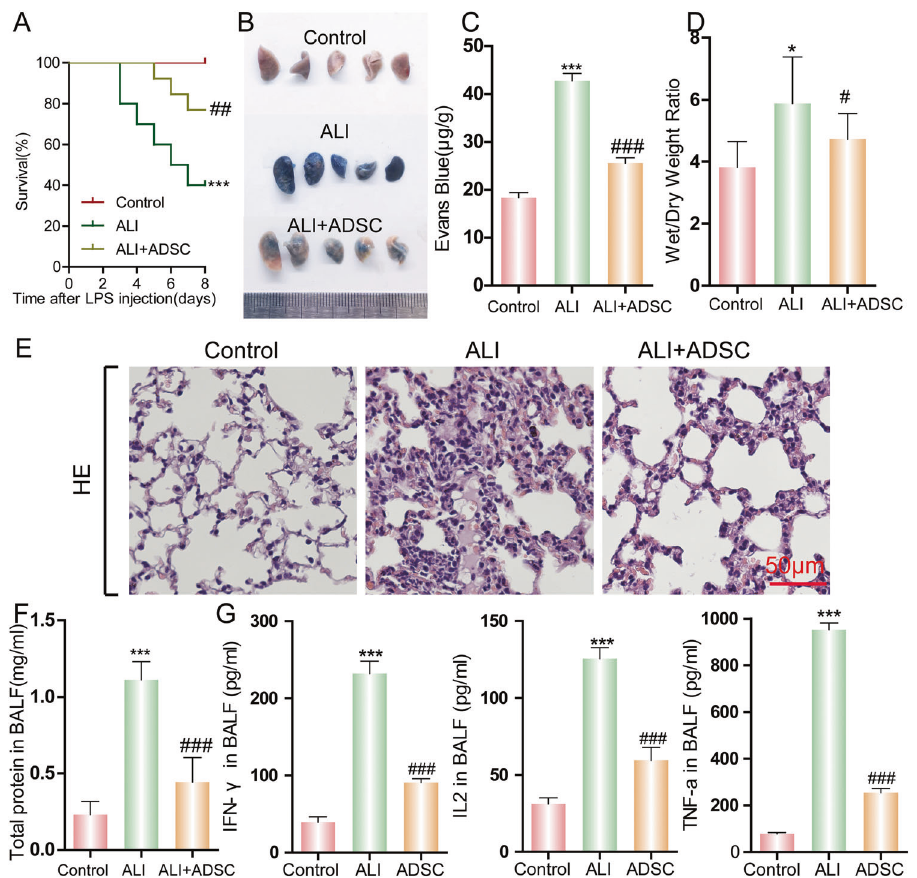
Fig. 2 The therapeutic ef fi cacy of ADSCs in LPS-induced ALI in mice. ALI in mice was induced by the airway administration of LPS. ADSCs were injected into the mouse tail vein to study its protective effect on ALI. A Mouse survival was monitored for 8 days (20% body weight loss). *** P < 0.001, ## P < 0.01. (determined by a log-rank (Mantel – Cox) Test). Acute lung tissue injury was evaluated by ( B ) Evans blue staining and ( C ) quanti fi cation. Evans blue concentration presents micrograms of Evans blue dye per gram of lung tissue. D The wet/dry weight ratio of lung was determined. E Pathological changes in the tissue were observed via H&E staining. F The total protein concentration was measured. G Concentration of in fl ammatory cytokines IFN- γ , IL-2, and TNF- α , was detected by ELISA. Data are shown as means ± SD ( n = 10), * P < 0.05, *** P < 0.001 vs control; # P < 0.05, ### P < 0.001 vs ALI. (determined by unpaired t test or one-way ANOVA with Tukey autolysosomes with the acidic pH will be indicated in red under a fl uorescent microscope. The results con fi rmed that autophagy activity (free yellow spots in cytosol) was high in ADSCs (the blue structure was nuclear stained with DAPI). Furthermore, the number of autophagosomes and autolysosomes (free red spots) was signi fi cantly reduced in ADSCs with Becn-1 shRNA (Fig. 4B). The WB results also showed that the level of autophagy protein markers, Atg3 and LC3-II, were decreased following the knock- down of Becn-1. In addition, the level of autophagic cargo adapter p62 was increased (Fig. 4C). The observations of autophagy (indicted by red arrows) in ADSCs or Becn-1 knockdown ADSCs were consistent under an electron microscope (Fig. 4D). These data suggest that ADSCs have a direct anti-in fl ammatory effect on alveolar epithelial cells. ADSC autophagy is required for this anti- in fl ammatory function. mTOR signaling maintained autophagy in ADSCs Discoveries over the last decade have demonstrated that the mammalian target of the rapamycin (mTOR) signaling pathway serves as a central regulator of cell metabolism, growth, proliferation, and survival [27]. The mTOR pathway is activated during various cellular processes and its function has been implicated in multiple diseases, including tumor formation, angiogenesis, insulin resistance, adipogenesis, and is deregulated in pathological conditions (e.g., cancer and type 2 diabetes). Since